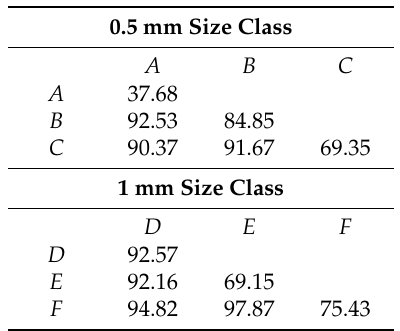
Table 3. Bray–Curtis dissimilarity of the clusters obtained for the 0.5 mm and the 1 mm size classes. The diagonal of the triangular matrix corresponds to within-cluster dissimilarity, and other cells are across-cluster dissimilarity.